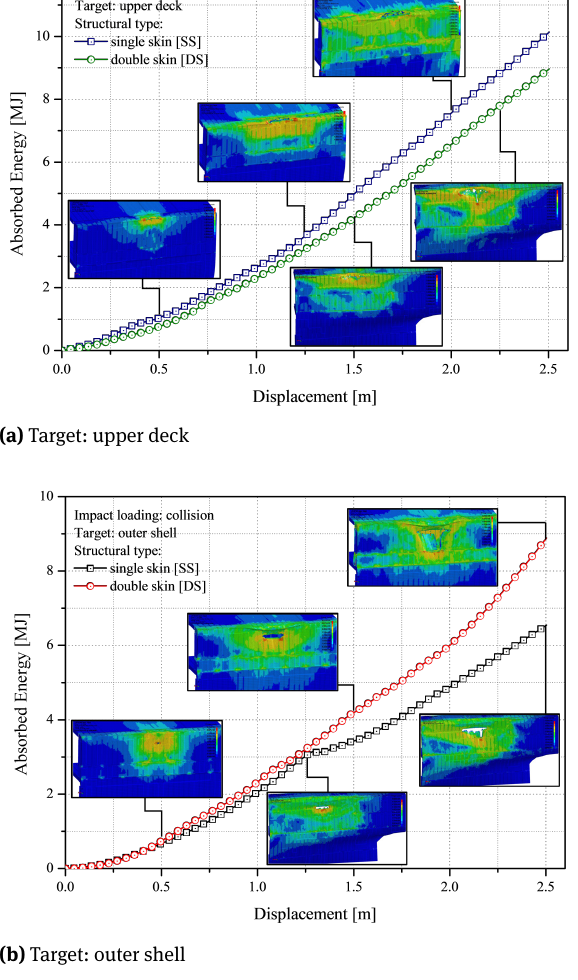
Figure 4: Results of the absorbed energy for two targets